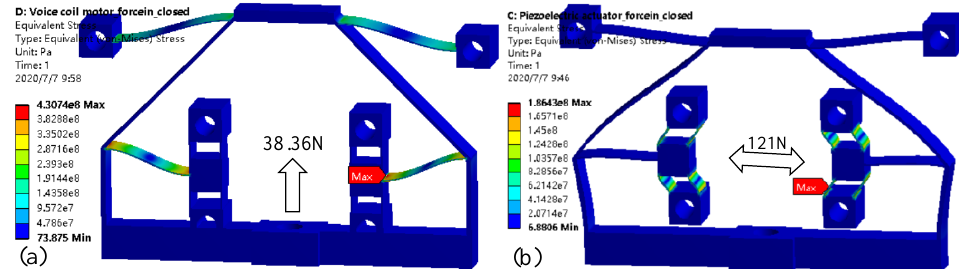
Figure 4. Stress distribution of ACPM while ( a ) actuating the input end of VCM with 38.36 N and fixing the input end of PEA, ( b ) driving the input end of PEA with 121 N and fixing the input end of VCM.